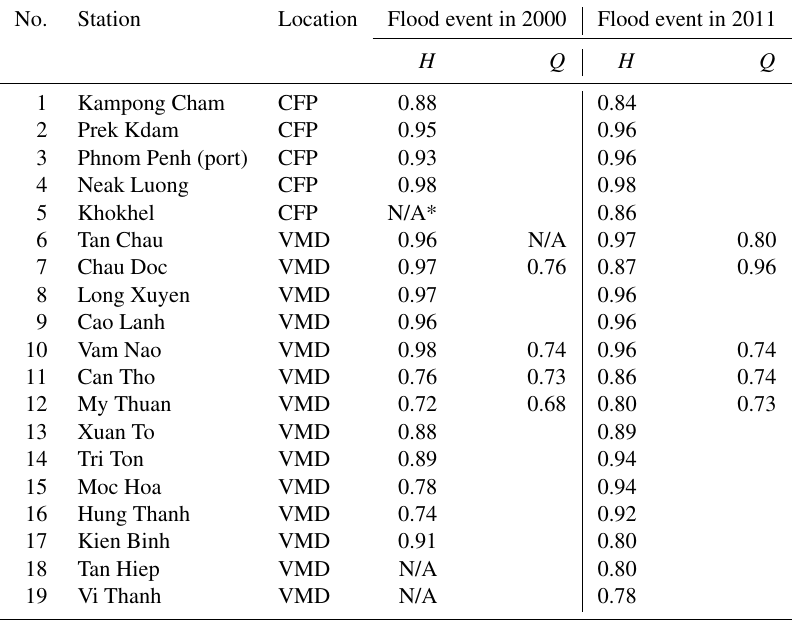
Table 1. Model performance: location, parameter and results for the two flood events in 2000 and 2011. Model performance is quantified by the Nash–Sutcliffe efficiency (NSE).